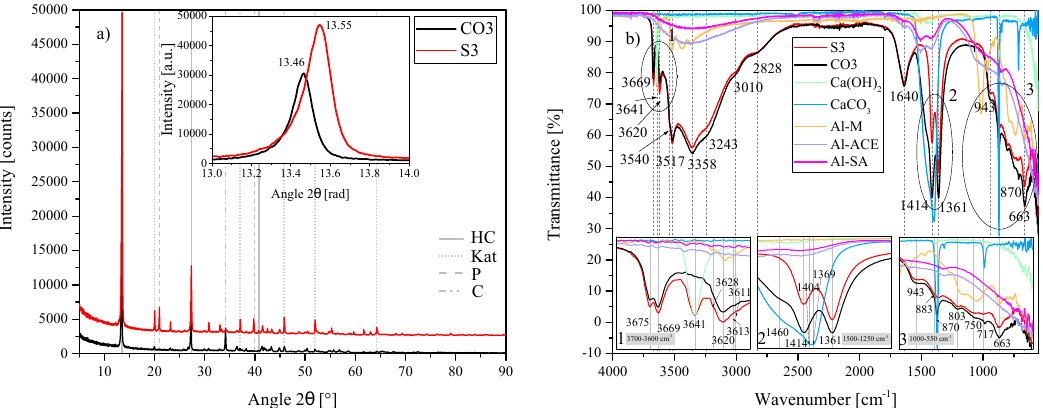
Figure 2. ( a ) XRD results of the HC-CO3-LDH plotted against the standard HC LDH S2 between 5 ◦ 2 θ and 90 ◦ 2 θ . Each scan is y-shifted by 2500 counts. The inset depicts the primary LDH peaks and change in position. HC = hydrocalumite, Kat = katoite, P = portlandite and C = calcite. ( b ) FTIR-ATR scans of the HC-CO3-LDH plotted against the standard HC LDH S2 and the starting materials used (Al(OH) 3 ,Ca(OH) 2 andCaCO 3 ) between 4000cm − 1 and 550cm − 1 . The three insets show the regions: ( 1 ) 3700cm − 1 – 3600cm − 1 , ( 2 ) 1500cm − 1 – 1250cm − 1 , ( 3 ) 1000cm − 1 – 550cm − 1 in detail. Dashed and solid grey lines indicate the maxima of vibrations.